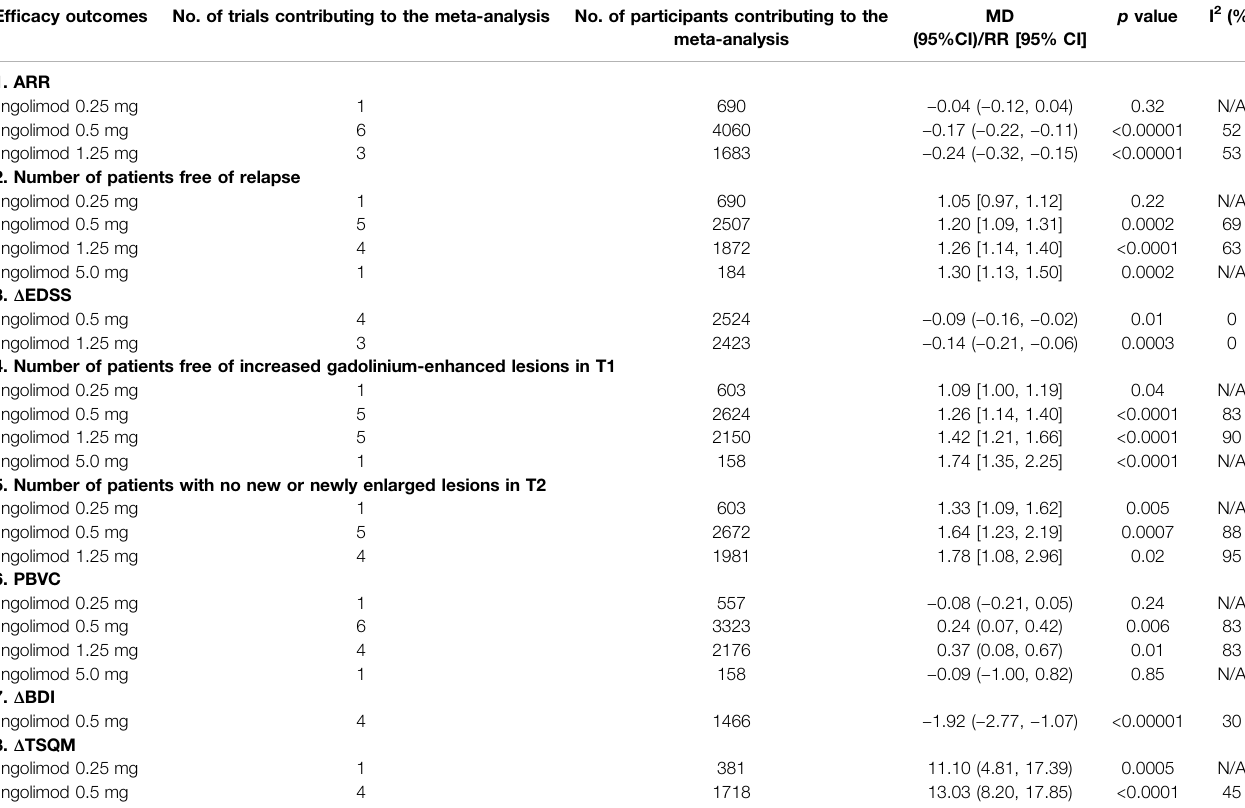
TABLE 2 | Effects sizes from meta-analysis of ef fi cacy outcomes; from all trials using random effects models. Ef fi cacy outcomes No. of trials contributing to the meta-analysis No. of participants contributing to the